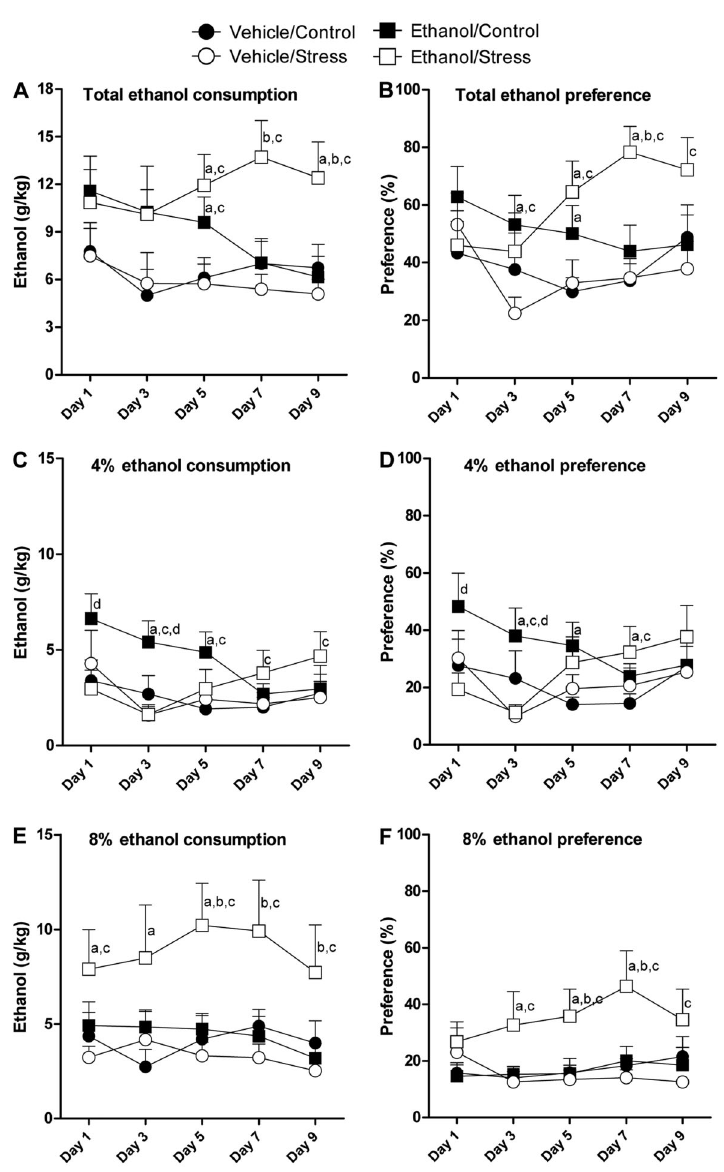
factor (F 4,112 =7.3, P p 0.05). However, no differences were